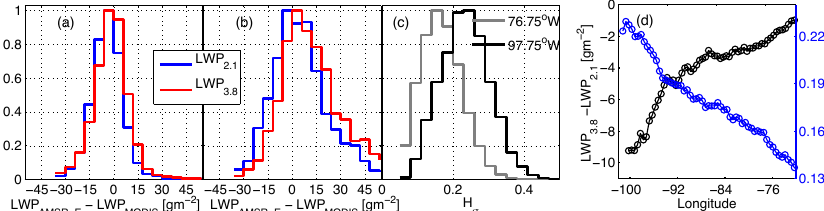
Fig. 4: Normalized histograms for the differences between AMSR-E and MODIS LWP 510 Fig. 4. Normalized histograms for the differences between AMSR-E and MODIS LWP for two 4 ◦ × 3 ◦ regions: (a) coastal area centered at 76.75 ◦ W, 23.75 ◦ S, and (b) offshore area centered at 97.75 ◦ W, 23.75 ◦ S. Red and blue histograms correspond to LWP AMSR-E –LWP 3 . 8 for two 4˚x3˚ regions: a) coastal area centered at 76.75˚W, 23.75˚S, and b) offshore area 511 and LWP AMSR-E –LWP 2 . 1 , respectively. (c) Normalized H σ histograms for the coastal (gray) and offshore (black) regions in (a) and (b) . centered at 97.75˚W, 23.75˚S. Red and blue histograms correspond to LWP AMSR-E - 512 (d) Mean westward variation of H σ (blue) and LWP 3 . 8 –LWP 2 . 1 along 21.25–26.25 ◦ S. Figures are constructed from cloudy scenes only (CF > 98%). LWP 3.8 and LWP AMSR-E -LWP 2.1 , respectively. c) Normalized H σ histograms for the 513 coastal (gray) and offshore (black) regions in Figs. 4a and b. d) Mean westward variation 514 of H σ (blue) and LWP 3.8 -LWP 2.1 along 21.25˚-26.25˚S. Figures are constructed from 515 cloudy scenes only (CF>98%). 516